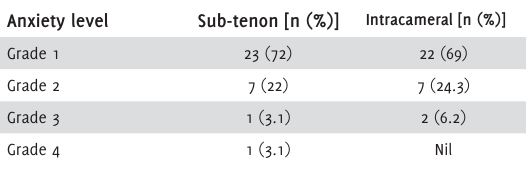
for both groups of patients by using the same medical staff for all